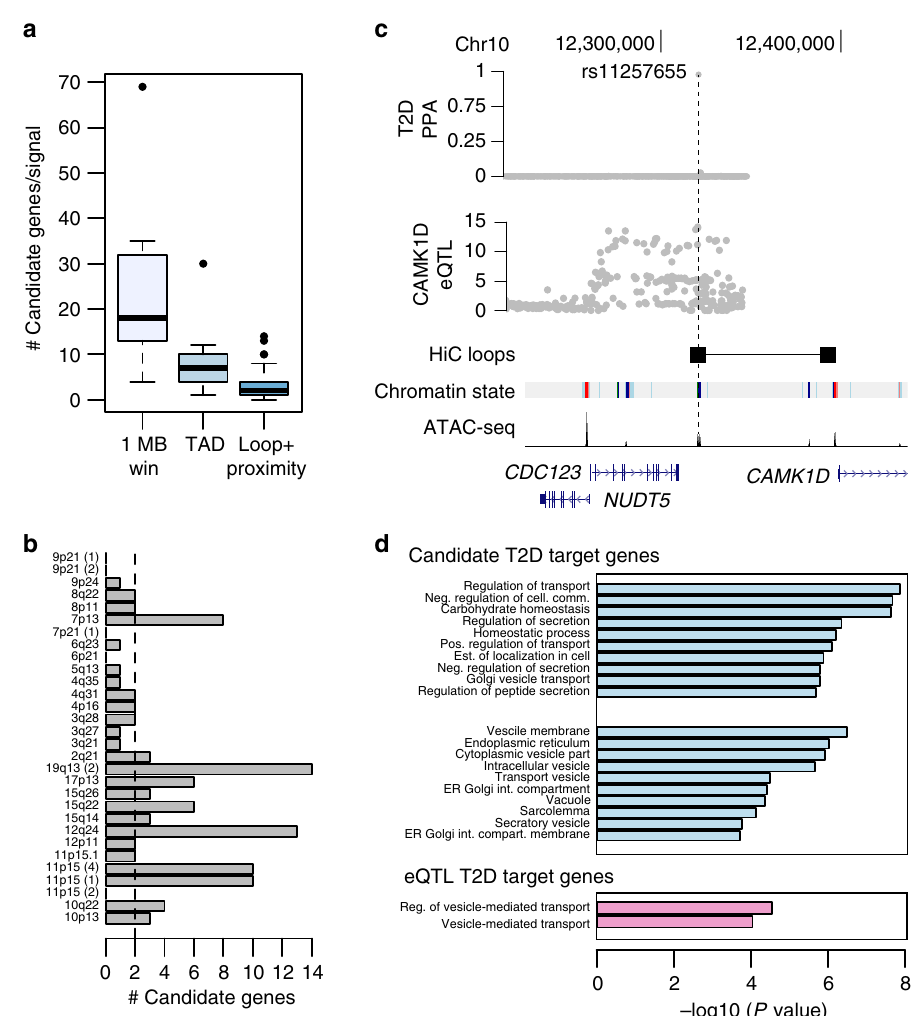
Fig. 4 Target genes of type 2 diabetes islet enhancer signals are involved in protein secretion and transport. a Prioritizing candidate target genes using chromatin loops and promoter-proximity (Loop + proximity; avg = 2) greatly reduces the number of genes obtained when using a 1 MB window (1 Mb win; avg = 18) or topologically associating domain boundaries (TAD; avg = 7). b T2D islet enhancer signals formed chromatin loops with, or were in proximity to, an average of two target genes. c At the CDC123/CAMK1D locus T2D islet enhancer variant rs11257655 was in a chromatin loop to the CAMK1D promoter and an islet eQTL for CAMK1D expression. Probabilities (PPA) that variants are causal for T2D risk (top) and variant association (-log10 P ) with islet expression level of CAMK1D (middle). d Candidate target genes of T2D enhancer signals were strongly enriched for biological processes related to protein secretion, protein transport, vesicles and vesicle membranes, and endoplasmic reticulum (FDR q < 0.2) (top), and candidate genes with islet eQTL evidence were speci fi cally enriched for vesicle-mediated transport (FDR q < 0.2) (bottom). Boxplots show the median, and third and fi rst quartiles. Source data are provided as a source data fi